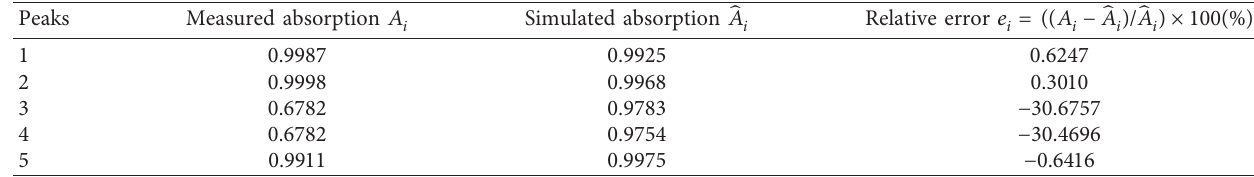
Table 5: The actual measurement and simulation data for absorption rate of each resonance peak. Peaks